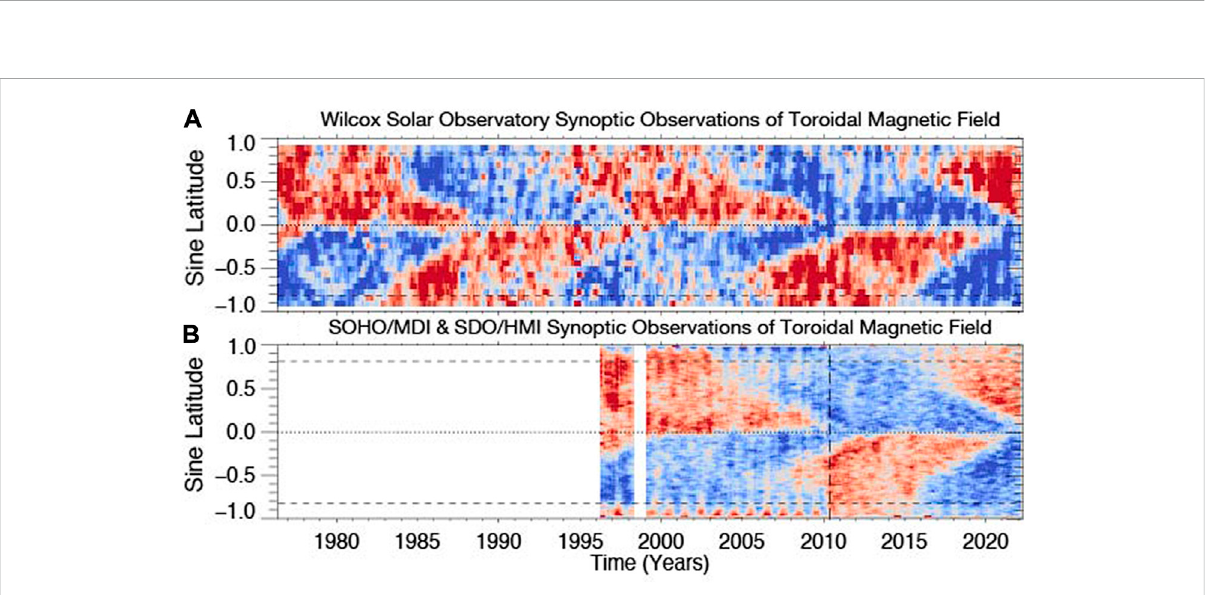
FIGURE 4 Comparing and contrasting the WSO toroidal magnetic fi eld [Panel (A) ] and version derived from the higher-resolution full-disk space observations SOHO/MDI and SDO/HMI [Panel (B) ] with the latter described by Liu and Scherrer (2022) updated to the present. The vertical dashed line in Panel B indicates the transition from observations from SOHO/MDI (prior to May 2010) and SDO/HMI (following May